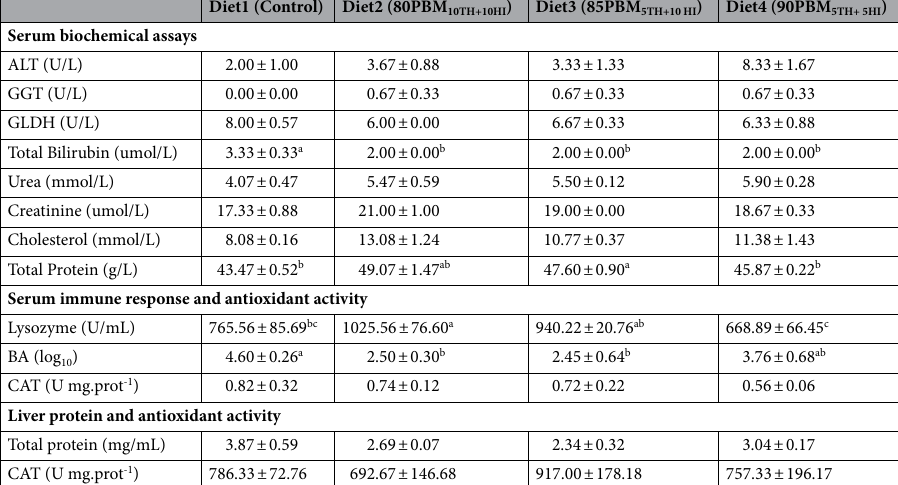
Table 7. Biochemical assays, immune response and antioxidant activity of barramundi fed with a gradient PBM diets, concurrently supplemented with TH and HI larvae meal for six weeks. Results are expressed as mean ± SE (standard error) (n = 3). Means with different superscripts letters in the same row indicates significant difference at P < 0.05. Alanine transaminase, ALT; gamma-glutamyl transferase, GGT; glutamate dehydrogenase, GLDH, bactericidal activity, BA and catalase activity,